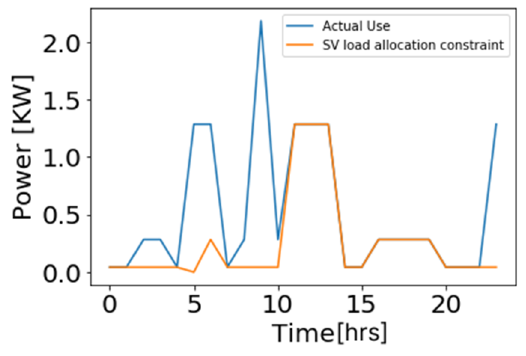
Figure 3. Power usage with the proposed Shapley Value (SV) load allocation algorithm vs. real usage according with the REDD [31] database.